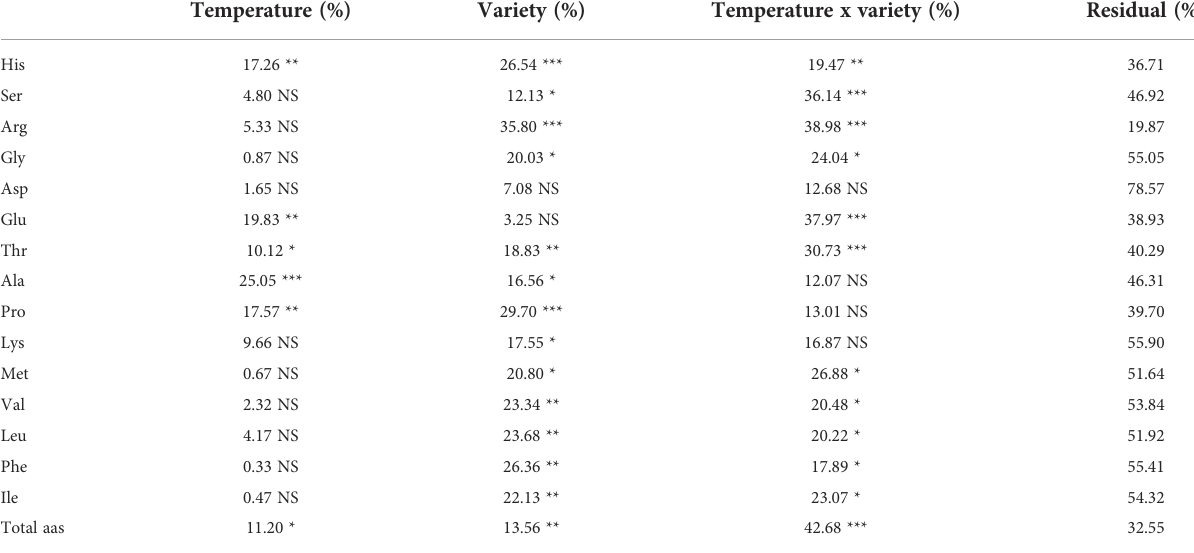
TABLE 4 Percentage of variance attributable to temperature, variety and their interaction for each amino acid of the three pepper cultivars. Temperature (%) Variety (%) Temperature x variety (%) Residual